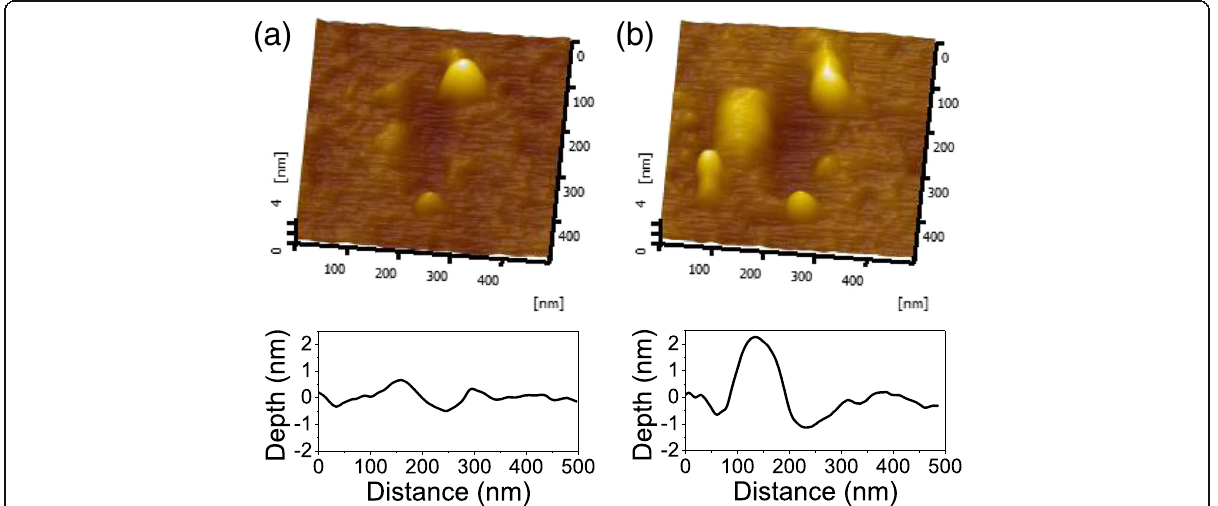
Fig. 4 AFM images and the corresponding cross-section profiles of wear scars on amorphous silica surface formed after sliding 200 cycles ( a ) and 2000 cycles ( b ). Relative humidity (RH) was 60%, imposed load was 2 μ N, sliding amplitude was 200 nm, and the sliding speed was 0.8 μ